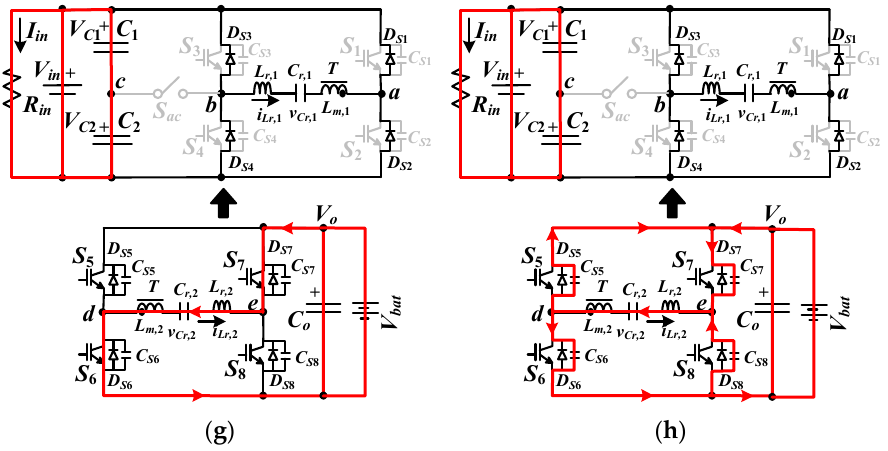
Figure 7. Equivalent circuits under backward power operation: ( a ) state 1; ( b ) state 2; ( c ) state 3; ( d ) state 4; ( e ) state 5; ( f ) state 6; ( g ) state 7; ( h ) state 8.